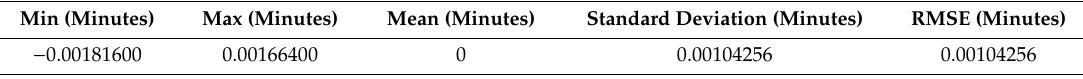
Table 10. Statistical values of the residuals for the latitude coordinates resulting from datum transformation OSPM / ED50 to OSPM / WGS84 based on a simplified approach (translation).